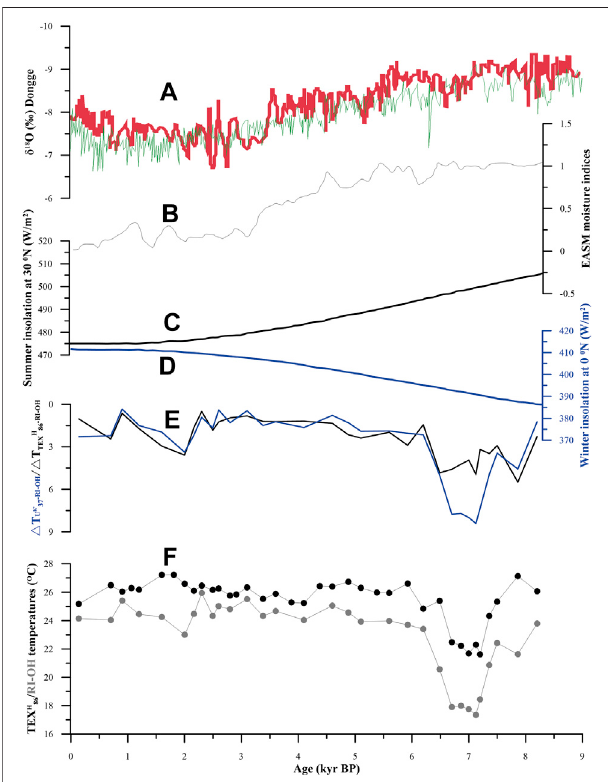
FIGURE 5 | Comparison of sea surface and subsurface temperature differencesbetweenTEX H 86 andRI-OH[ Δ TEX H ( ° C)]andbetweenU K ’ 37 and 86 − RI − OH RI-OH [ Δ U K ’ ( ° C)] from core C14 (U K ’ 37 SST from core DGKS9604 in the 37 − RI − OH study area; Yu et al., 2009) with other paleoclimate data. (A) δ 18 O records from Dongge Cave stalagmites, China (green: Wang et al., 2005; red: Dykoski et al., 2005); (B) the synthesized East Asian summer monsoon (EASM) moisture indices (Wang et al., 2010); (C) summer (June) insolation at 30 ° N (Berger and Loutre, 1991); (D) winter (December) insolation at 0 ° N (Berger and Loutre, 1991); (E) Δ TEX H ( ° C) (black) of core C14 and 86 − RI − OH Δ K ’ 37 SST from core DGKS9604; Yu et al., 2009); (F) U K ’ 37 − RI − OH ( ° C) (blue) (U temperatures from TEX H 86 (dark) and RI-OH (gray) in core C14.